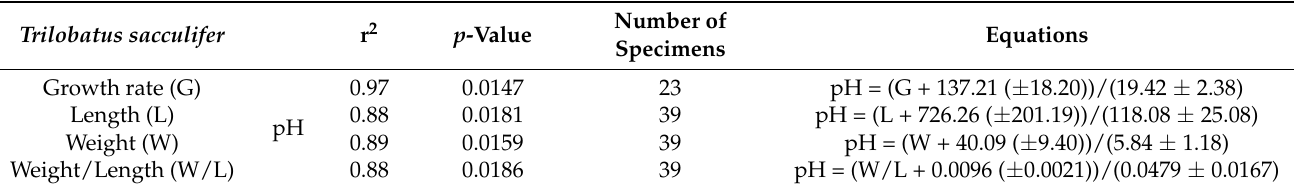
Table 1. Equations between individual biological indices (growth rate, length, weight, and W/L) and seawater pH, based on culture